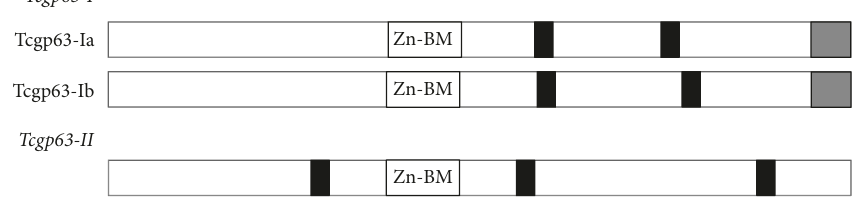
Figure 4: The TcGP63 family. The TcGP63 family consists of cell surface-localized, zinc-dependent metalloproteases also known as T. cruzi GP63-likeproteins.Thisfamilyhasatleasttwogroups:TcGP63-IandTcGP63-II.TcGP63-ImembershavetwopotentialN-glycosylationsites, whereas TcGP63-II members have three [50]. The glycosylphosphatidylinositol- (GPI-) anchor signal in the C-terminus position is depicted as grey boxes; it is absent in the TcGP63-II members. Predicted N-glycosylation sites are shown in black boxes. Zn-BM: zinc-binding motifs [VXAHEX 2 HA] associated with metalloprotease